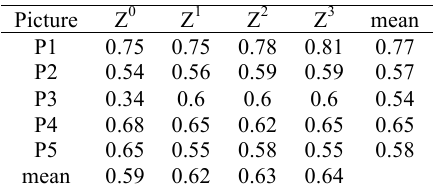
Table 2. Classification accuracies for 3-NN method, 10-best features selected using t-statistic.